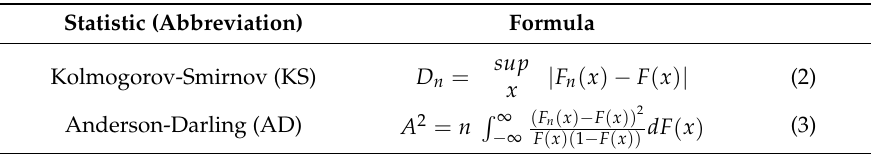
Table 3. Goodness-of-fit statistics used to evaluate the fitting ( F n denotes the empirical distribution function, F represents the fitted theoretical distribution function, sup abbreviates supremum which indicates the least element of x that is greater than or equal to all elements of x (“least upper bound”)). Statistic